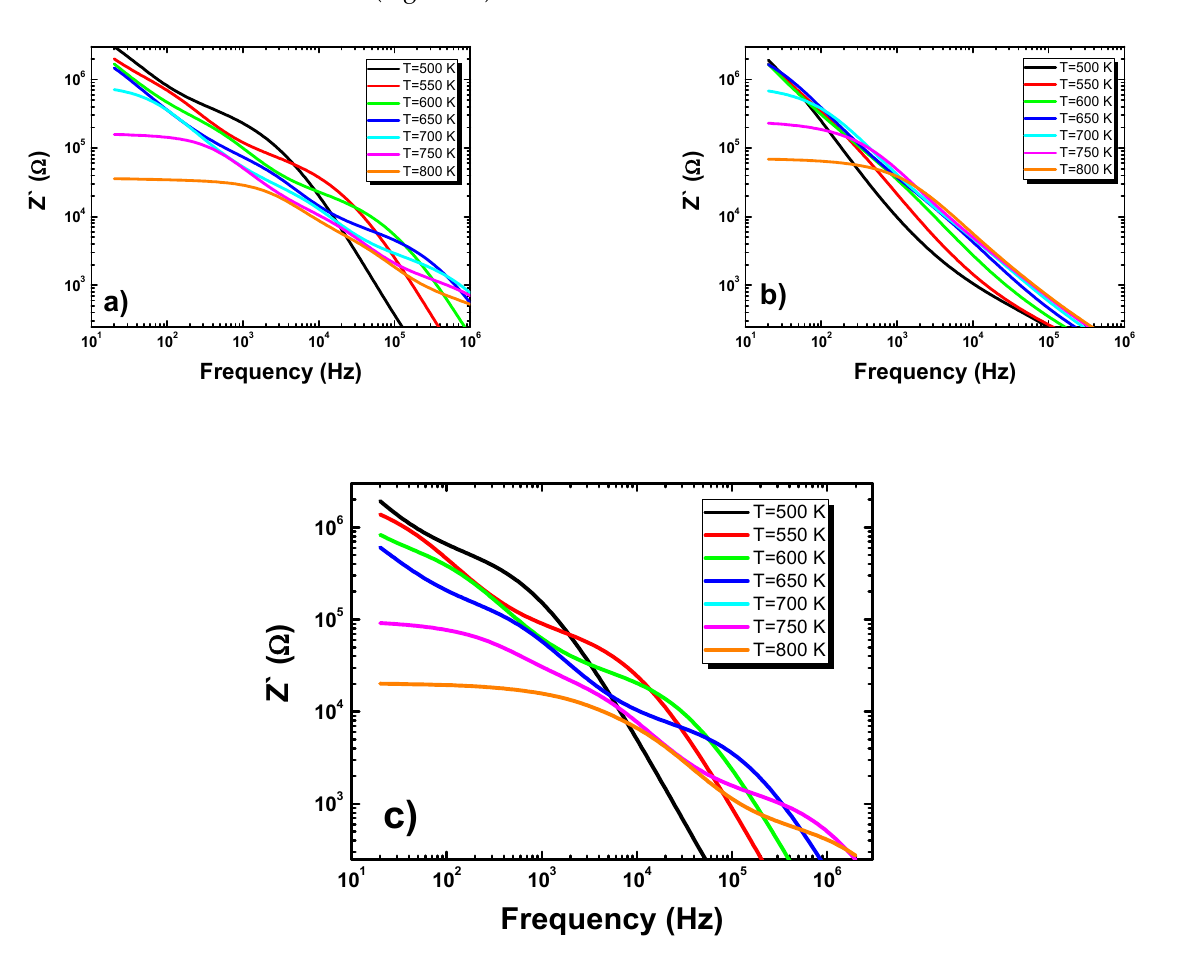
Figure 7. Frequency dependence of the real part of impedance measured at different temperatures for ( a ) europium-modified BLT4 ceramics, ( b ) hafnium-modified BLT4 ceramics, and ( c ) simultaneously hafnium- and europium-modified BLT4 ceramics.